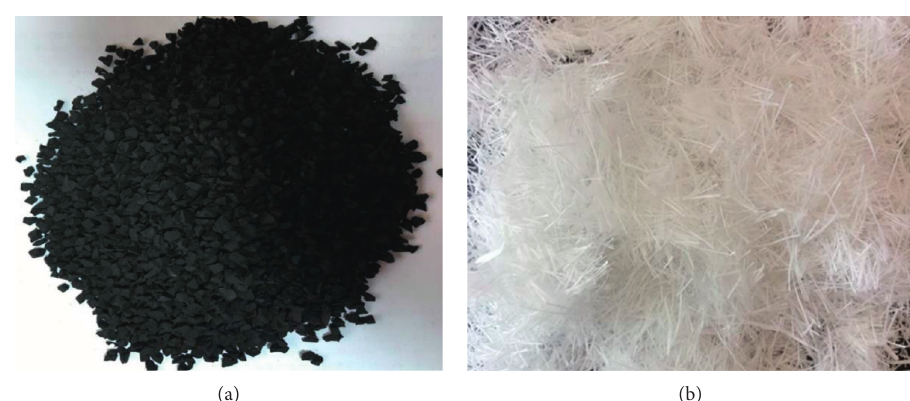
Figure 1: Rubber particles and polypropylene fibers. (a) Rubber particles. (b) Polypropylene fibers.